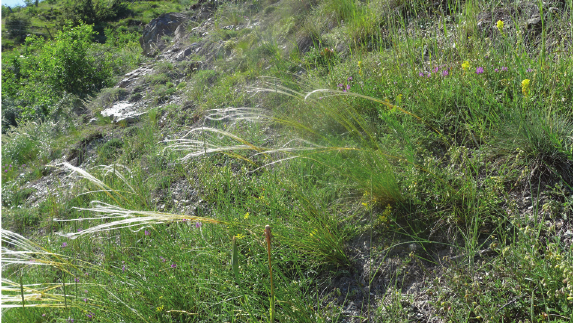
Figure 8. Subassociation stipetosum pennatae (Photo: M.